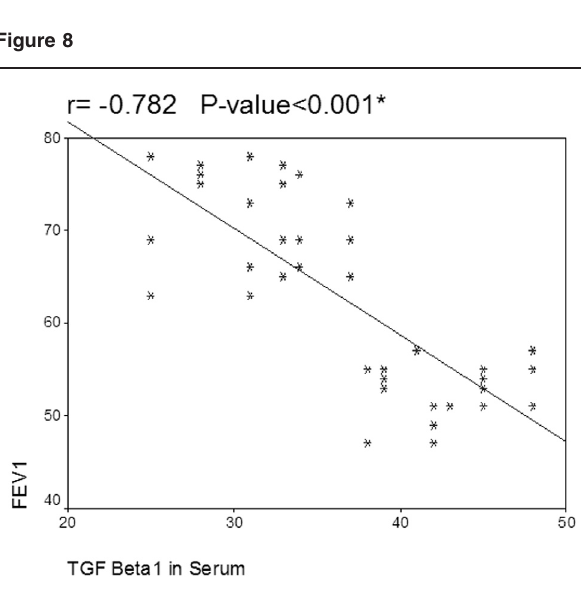
Correlation of transforming growth factor β 1 concentration (ng/ml) in serum and FEV 1 % of predicted.